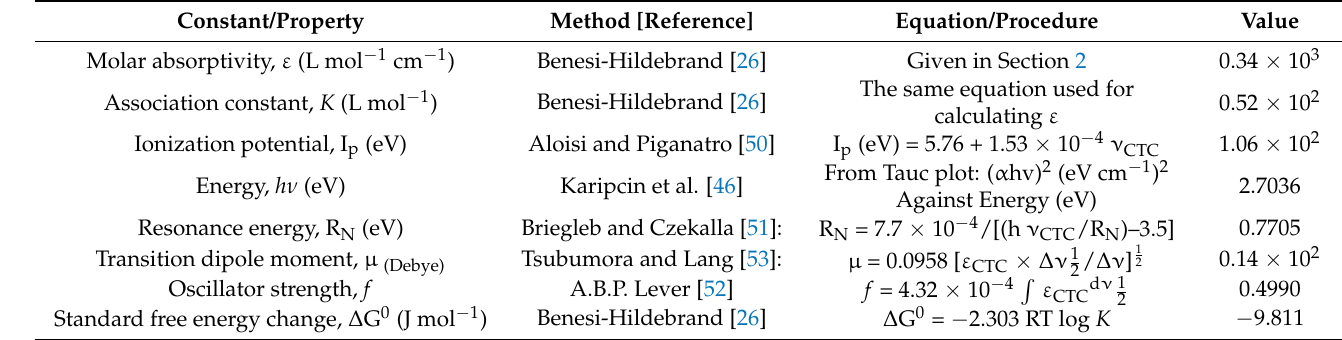
Table 2. Electronic constants/properties of CTC of LOR with DDQ.